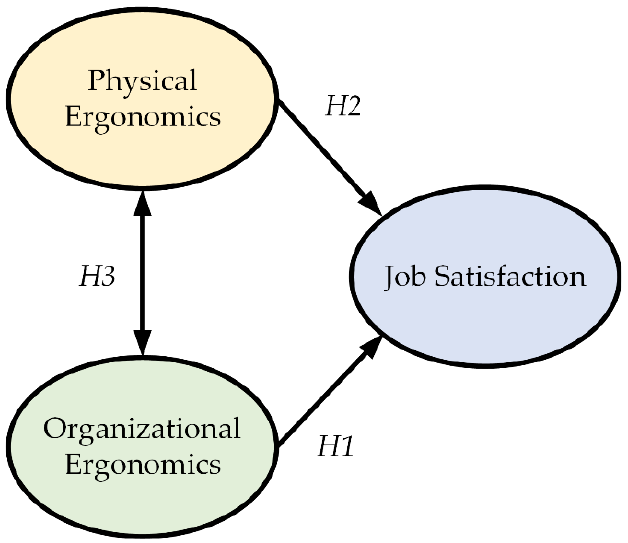
Figure 1. Relationship between ergonomic aspects and job satisfaction.